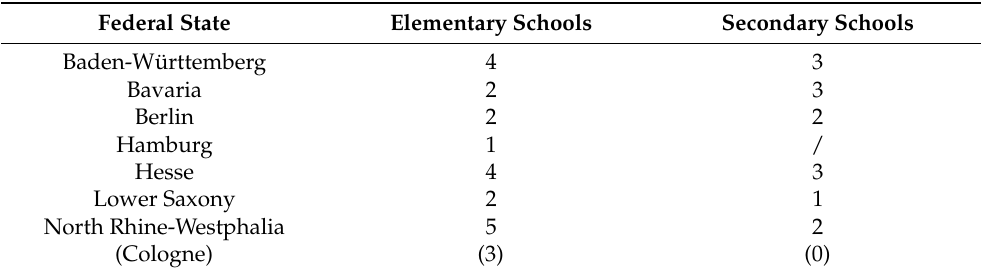
Table 1. Number of elementary and secondary schools implementing German-Italian bilingual programs in different federal states of Germany. In brackets: number of schools in Cologne among the ones in North